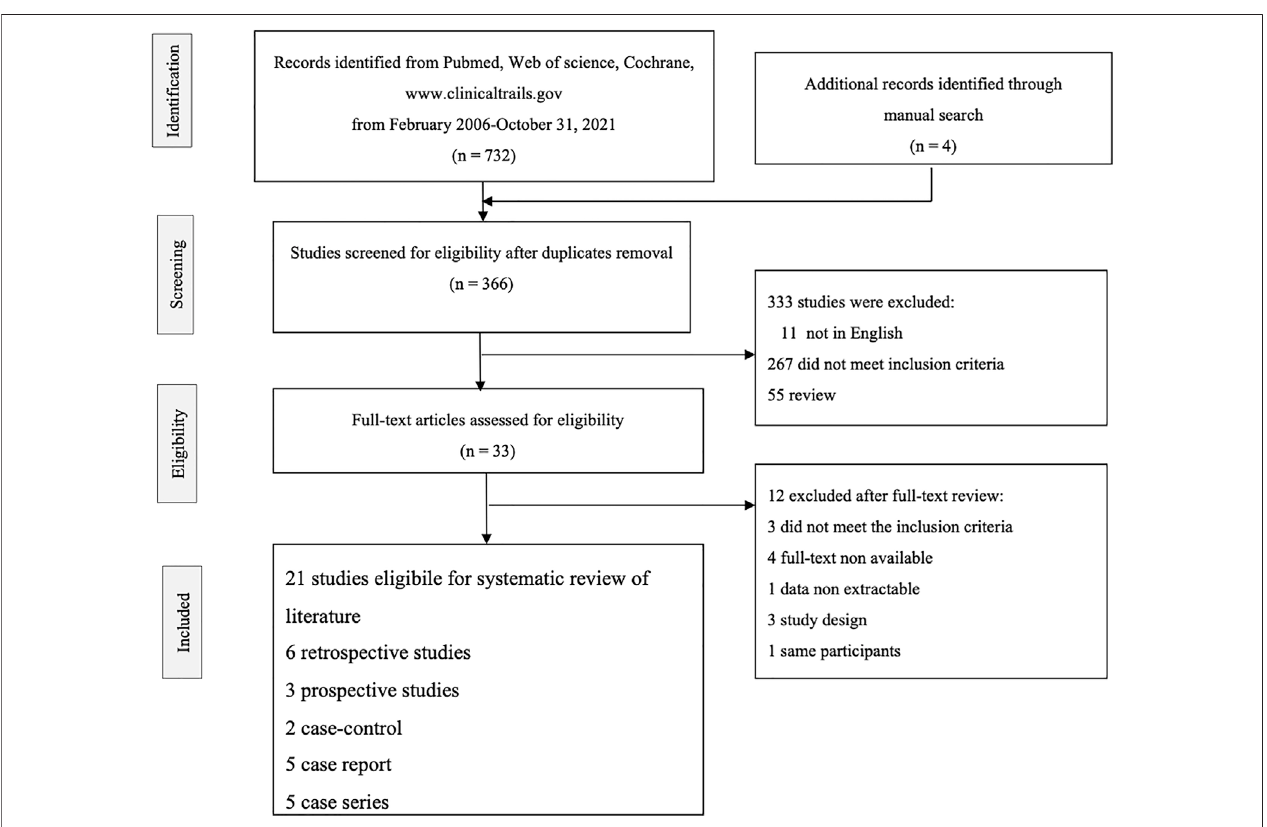
FIGURE 1 | Flow diagram of study